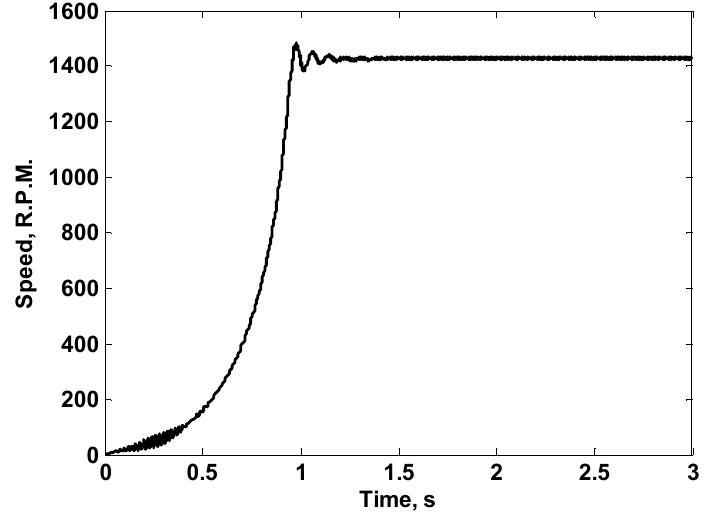
Figure 30. Motor Speed with an Open-Circuit in one of the Motor Phases.